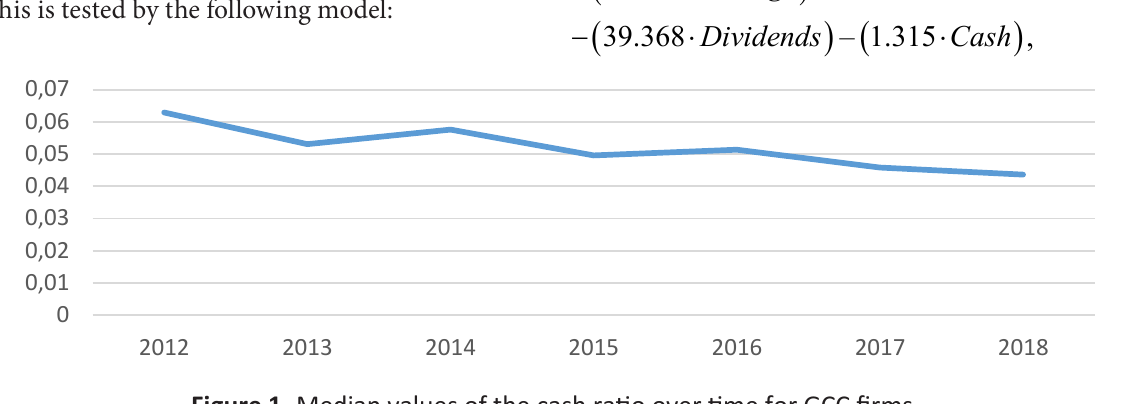
Figure 1. Median values of the cash ratio over time for GCC